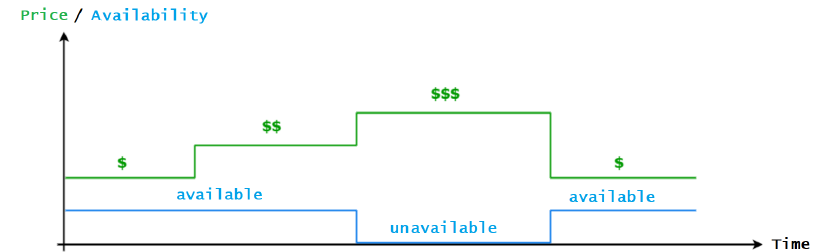
Figure 5. Relation between recharge price (low—$, medium—$$ or, high—$$$) according to avail-